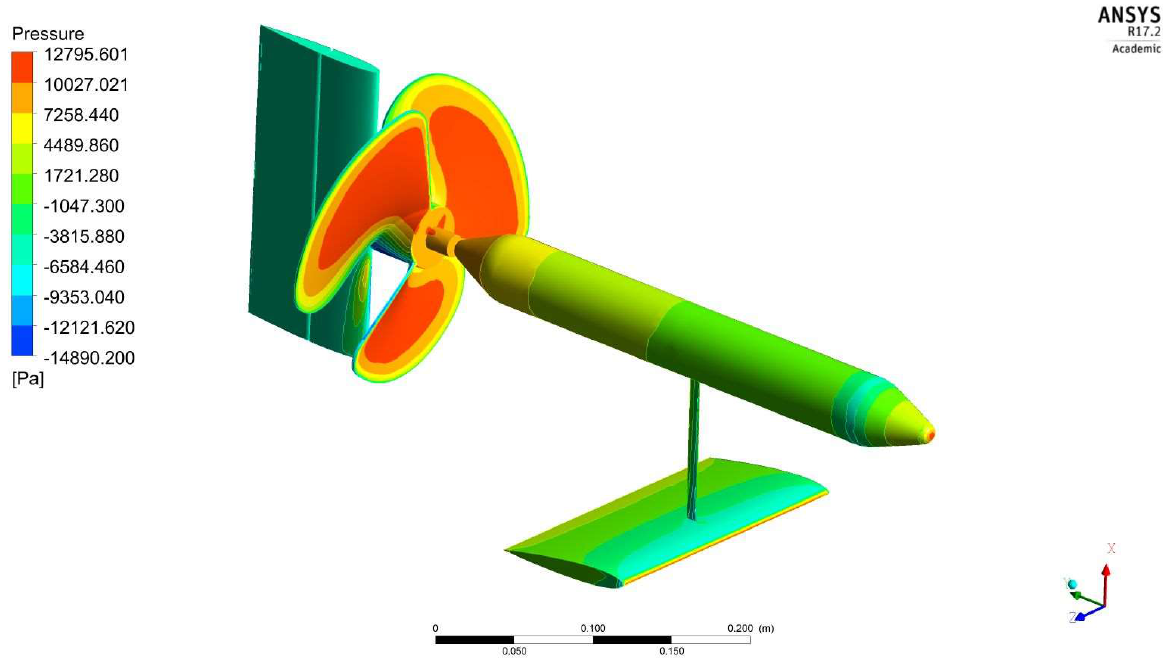
Figure 37. An isometric projection of pressure distributions on advanced US with horizontal fins—slow speed altitude increment operation.